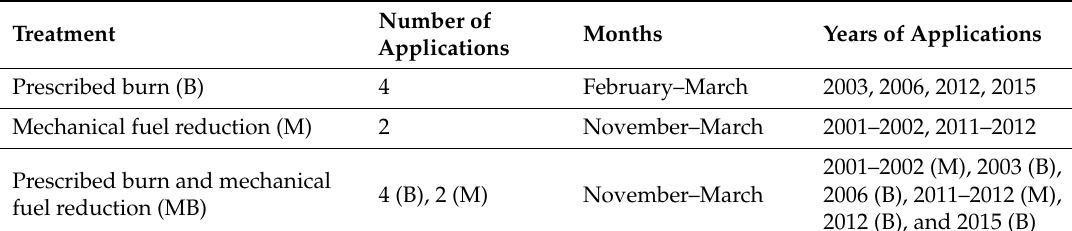
Table 1. Treatment frequency and timing for the Southern Appalachian Fire and Fire Surrogate Study site in Green River Game Land, Polk County, North Carolina. A control treatment (C), which was undisturbed during the study period, was also included.